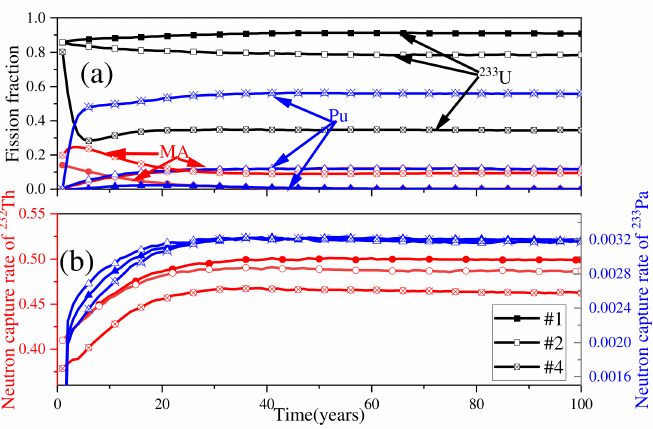
Figure 8. Evolution of fission fraction ( a ) and neutron capture rate of nuclides ( b ).